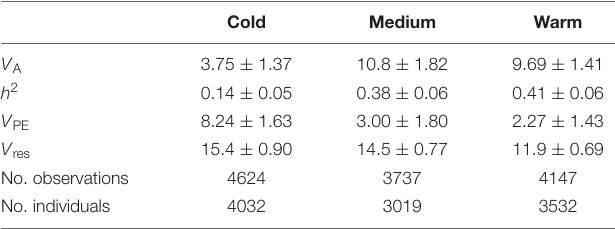
TABLE 1 | Variance components (and SE) from quantitative genetic analysis of egg-laying date, separately by temperature